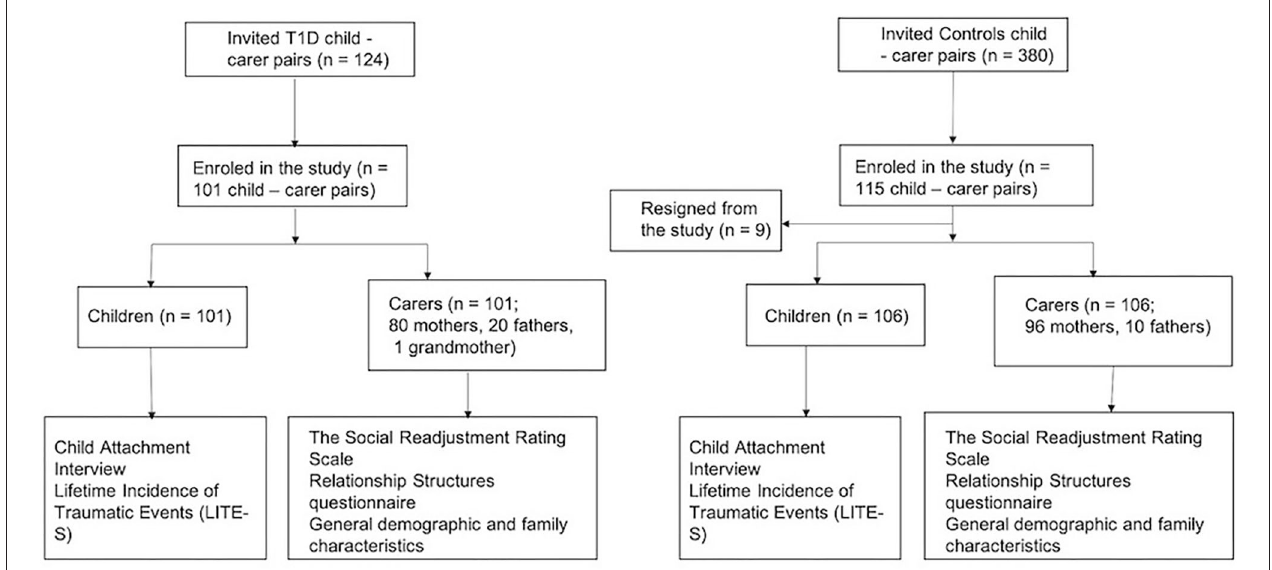
FIGURE 1 | The consort flow